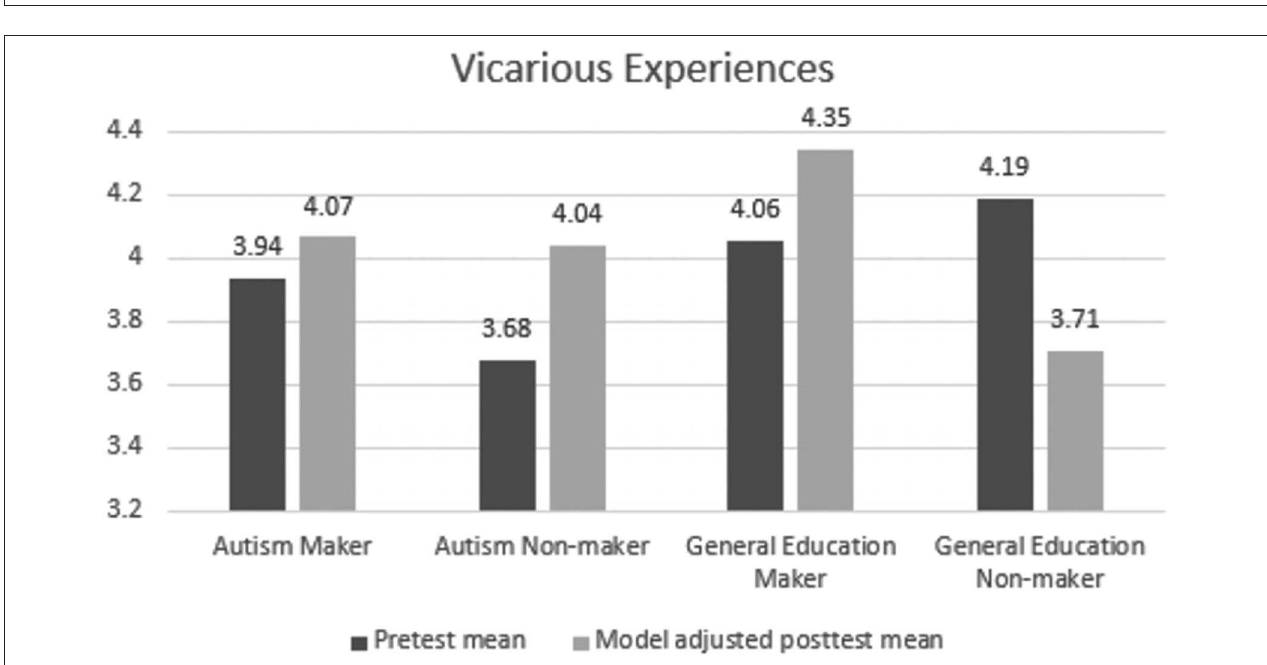
FIGURE 4 | Estimated means for the Technology and Engineering Outcomes construct.